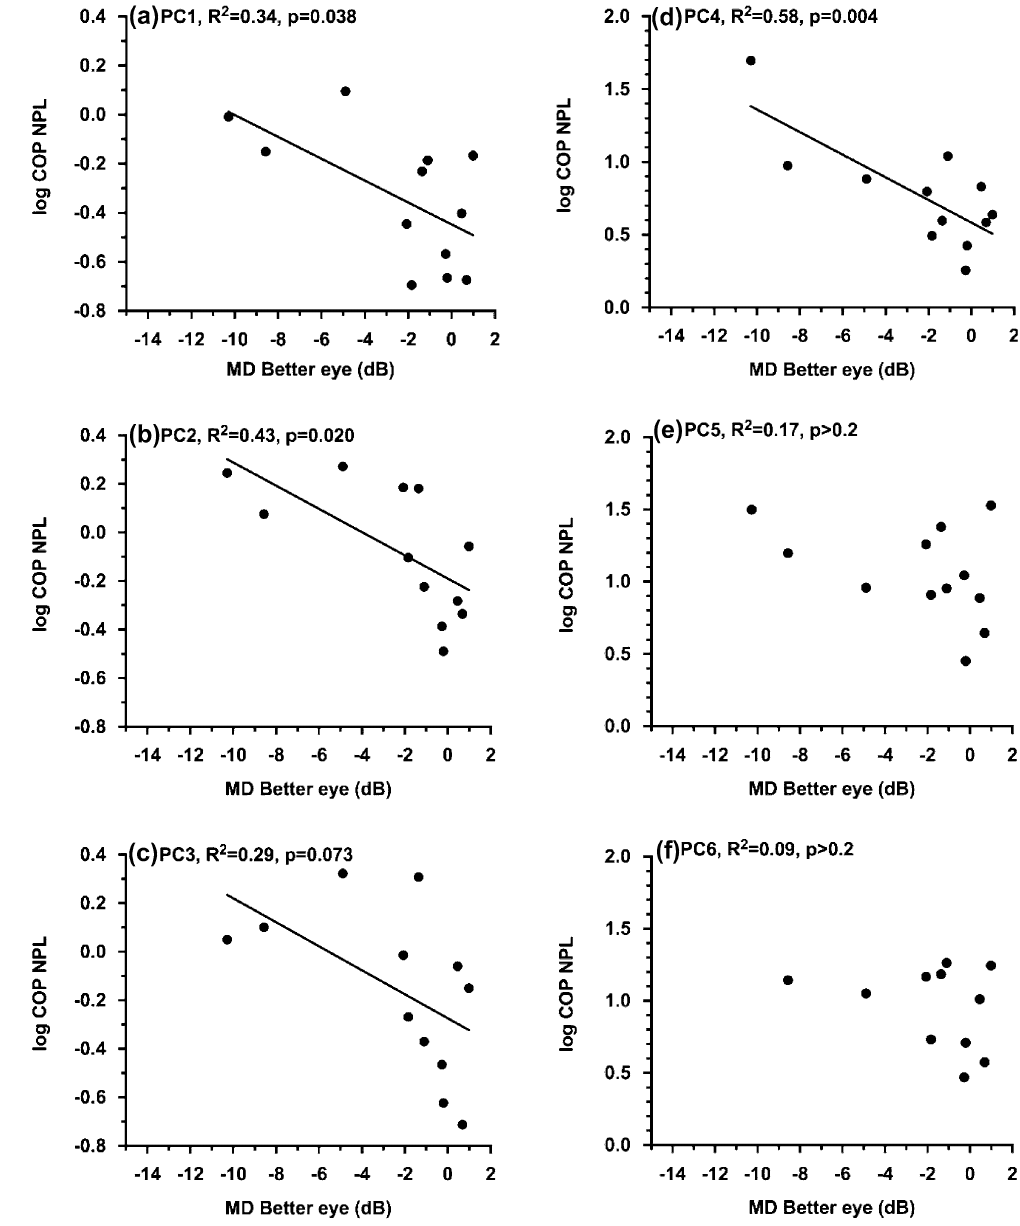
Figure 1. Association between visual field in the better eye (MD better eye) and normalized path length (COP NPL) when exposed to the 6 postural conditions (PC1, …, PC6). A more negative visual field median deviation (VF MD) value on the x-axis indicates worse visual field deficits. Note a significant correlation indicated by the line between COP NPL and MD better